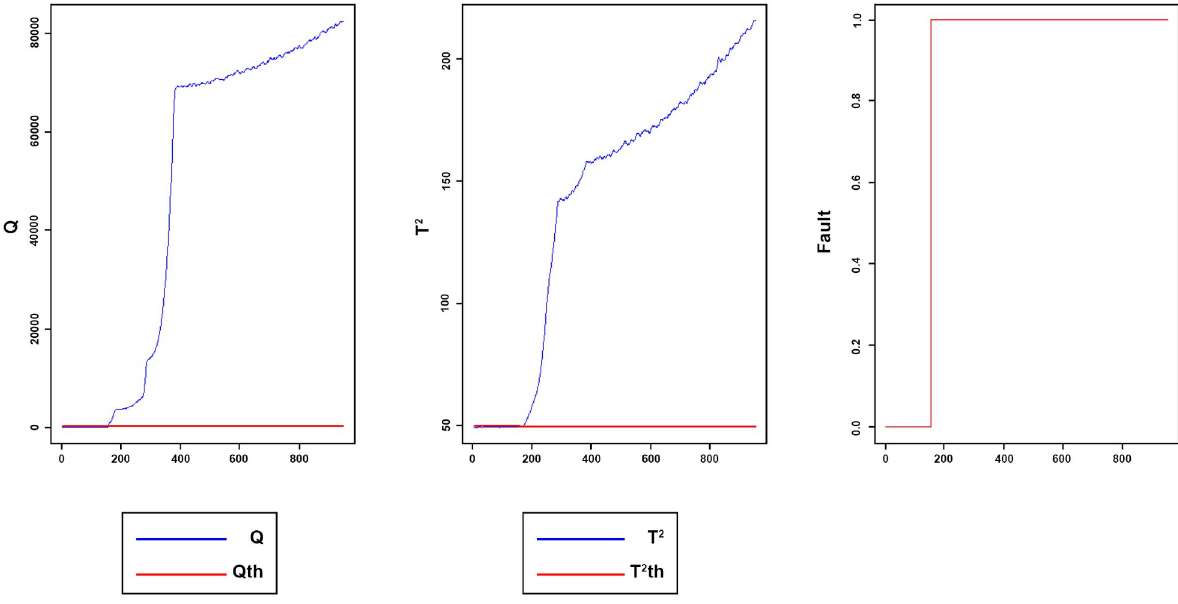
Fig 10. Monitoring performance of MWDPCA for fault